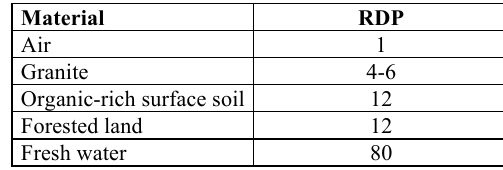
Table 2. Relative dielectric permittivities (RDPs) of the geological materials in El Escorial.